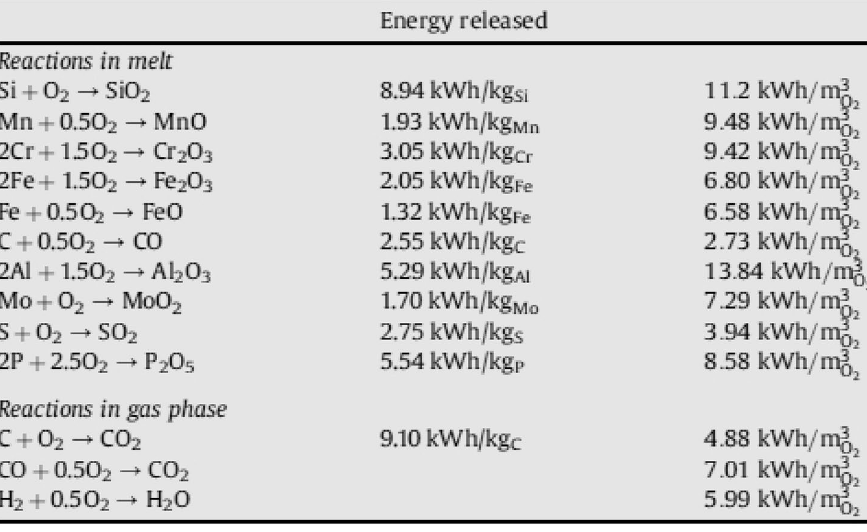
Fig. 2 Exothermic oxidation reactions and energy